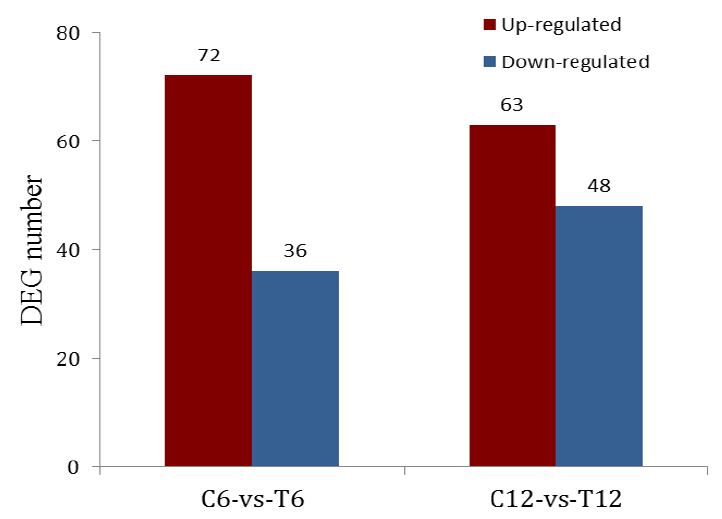
Figure 2. Statistical analysis of